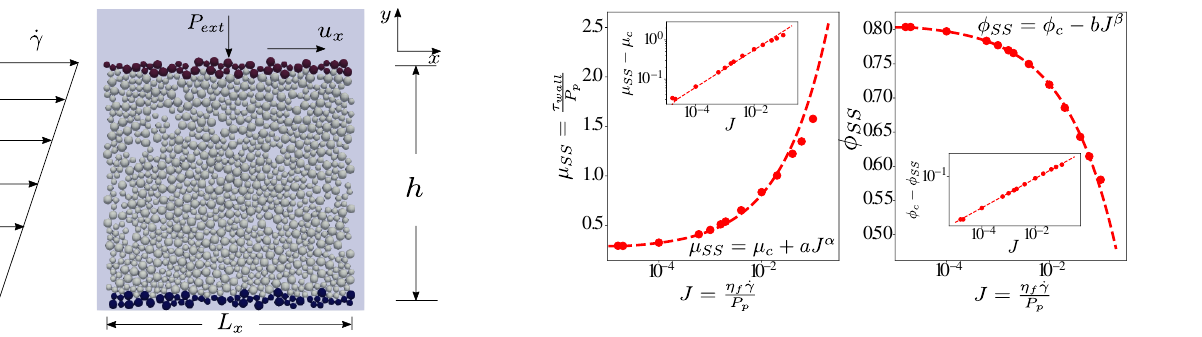
Figure 1. Our 2 D monolayer setup. The system (grey particles) is sheared at fixed applied vertical pressure P ext between an im- permeable fixed bottom wall (blue particles) and a permeable top wall free to move vertically to adjust the system area.